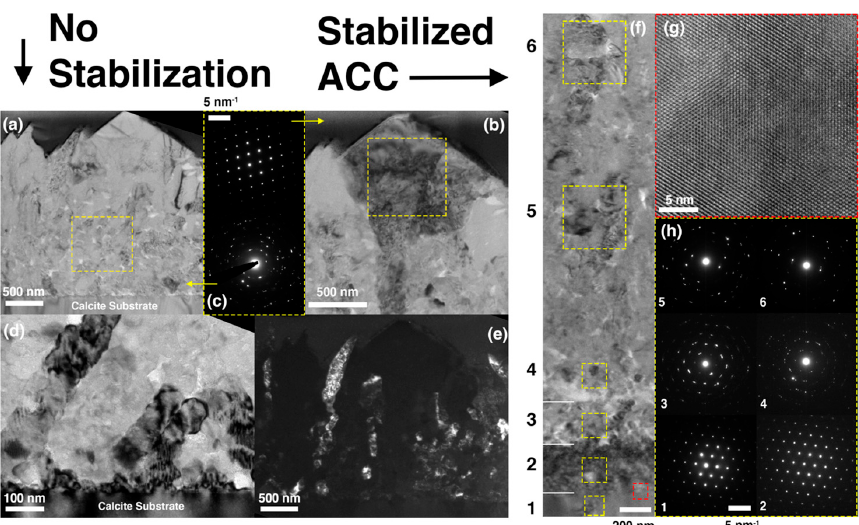
Figure 3. The microstructural and crystallographic characteristics of the coatings grown without ( a – e ) and with ( f – h ) the stabilized ACC, respectively. ( a – b ) The bright-field TEM images showing the entire coating cross section of the sample without ACC and corresponding selected area electron diffraction patterns obtained within the dotted boxes. The image in ( b ) was taken after aligning the sample along the zone axis of the grain having the faceted surface. The bright-field ( d ) and dark-field ( e ) TEM images showing the microstructures near the coating-substrate interface of the sample without ACC. ( f ) The bright-field TEM image showing the entire cross section of the sample with the stabilized ACC and ( h ) corresponding selected area electron diffraction patters obtained in the area within each dotted yellow box in ( f ). ( g ) The high-resolution TEM image taken on the coating-substrate interface in the region marked by the dotted red box in ( f ). In order to investigate the epitaxial relationship of the coated layer, the electron diffraction patterns in ( h ) were obtained without adjusting the specimen tilting angles once they are fixed along the zone axis of the substrate.